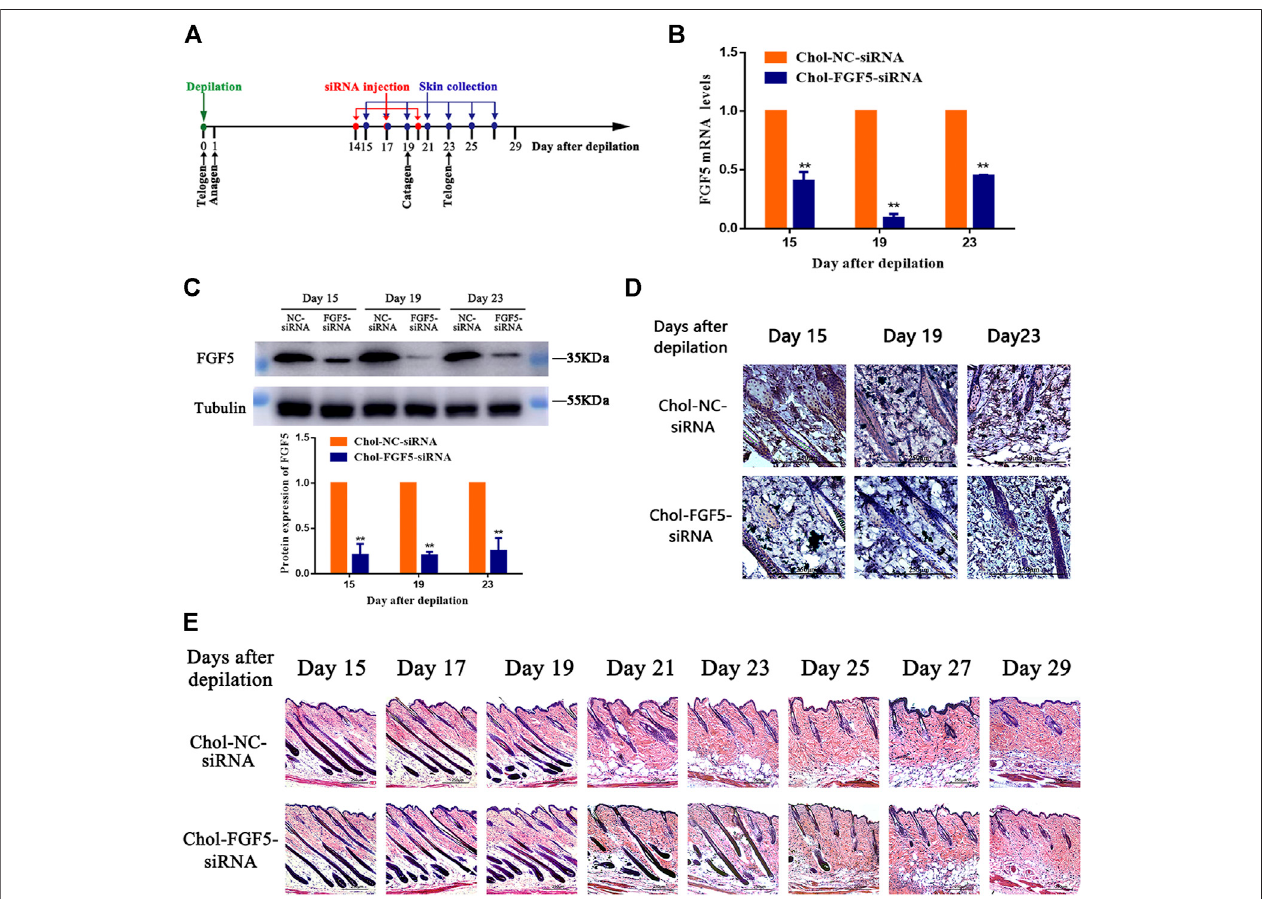
FIGURE 2 | Effects of Chol-FGF5-siRNA on the expression of FGF5 and hair follicle cycle in mouse skin (A) Diagram depicting the timeline in the establishment of the model used for the administration of Chol-siRNA and collection of skin samples. (B) Changes in FGF5 mRNA expression in mouse skin as determined by qPCR. Chol-FGF5-siRNA or Chol-NC-siRNA was delivered to the mouse skin by intradermal injection 14 days after depilation, and the mRNA level of FGF5 in the skin was measured by qPCR at the indicated times (C) Changes in FGF5 protein expression in mouse skin as determined by western blot. Chol-FGF5-siRNA or Chol-NC- siRNA wasdelivered tothe mouseskinby intradermal injection 14 days after depilation, and the expression ofFGF5 protein in theskin wasmeasured bywestern blotat theindicatedtimes.Theplotbelowtheblotshowsthequantitationoftheproteinintheblotasdetermined bygrayanalysis. (D) Immunohistochemicalstainingoftheskin tissue (E) HE staining of skin tissue showing the different phases of the hair follicle cycle. All graphical data are mean ± SD ( n (cid:2) 3). ** p < 0.01 vs. Chol-NC-siRNA.